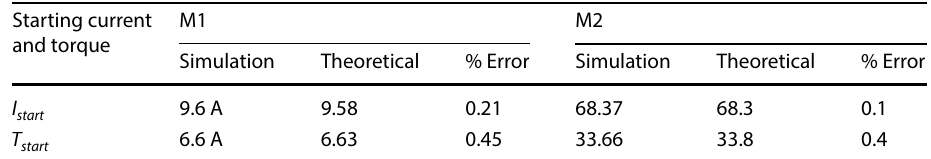
Starting current and torque